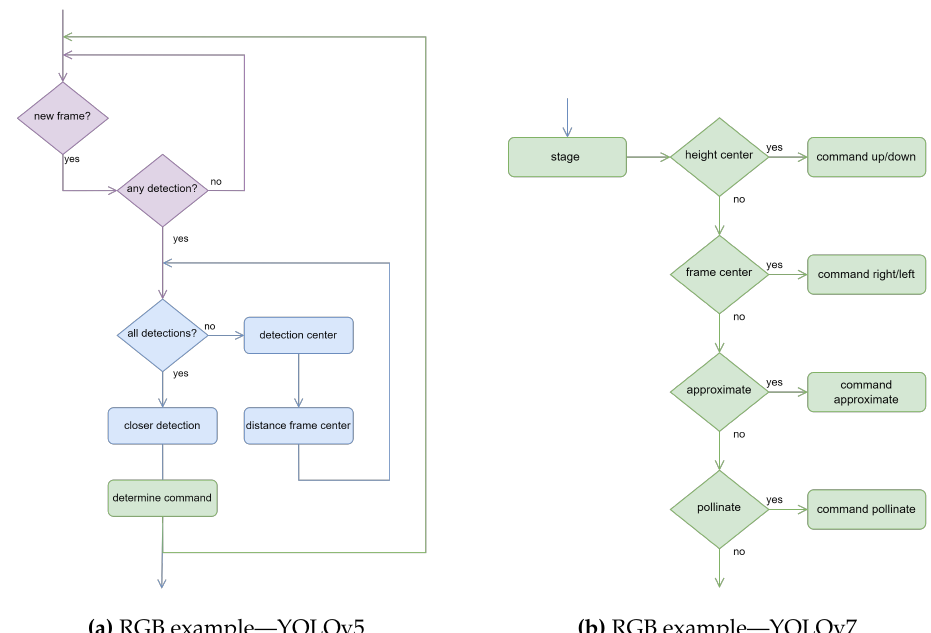
Figure 9. Flowcharts of the flight-control of the NAB. ( a ) Flowchart of the flight control algorithm according to the recognition of flowers in the pollination phase. ( b ) Flowchart of the stages to define the